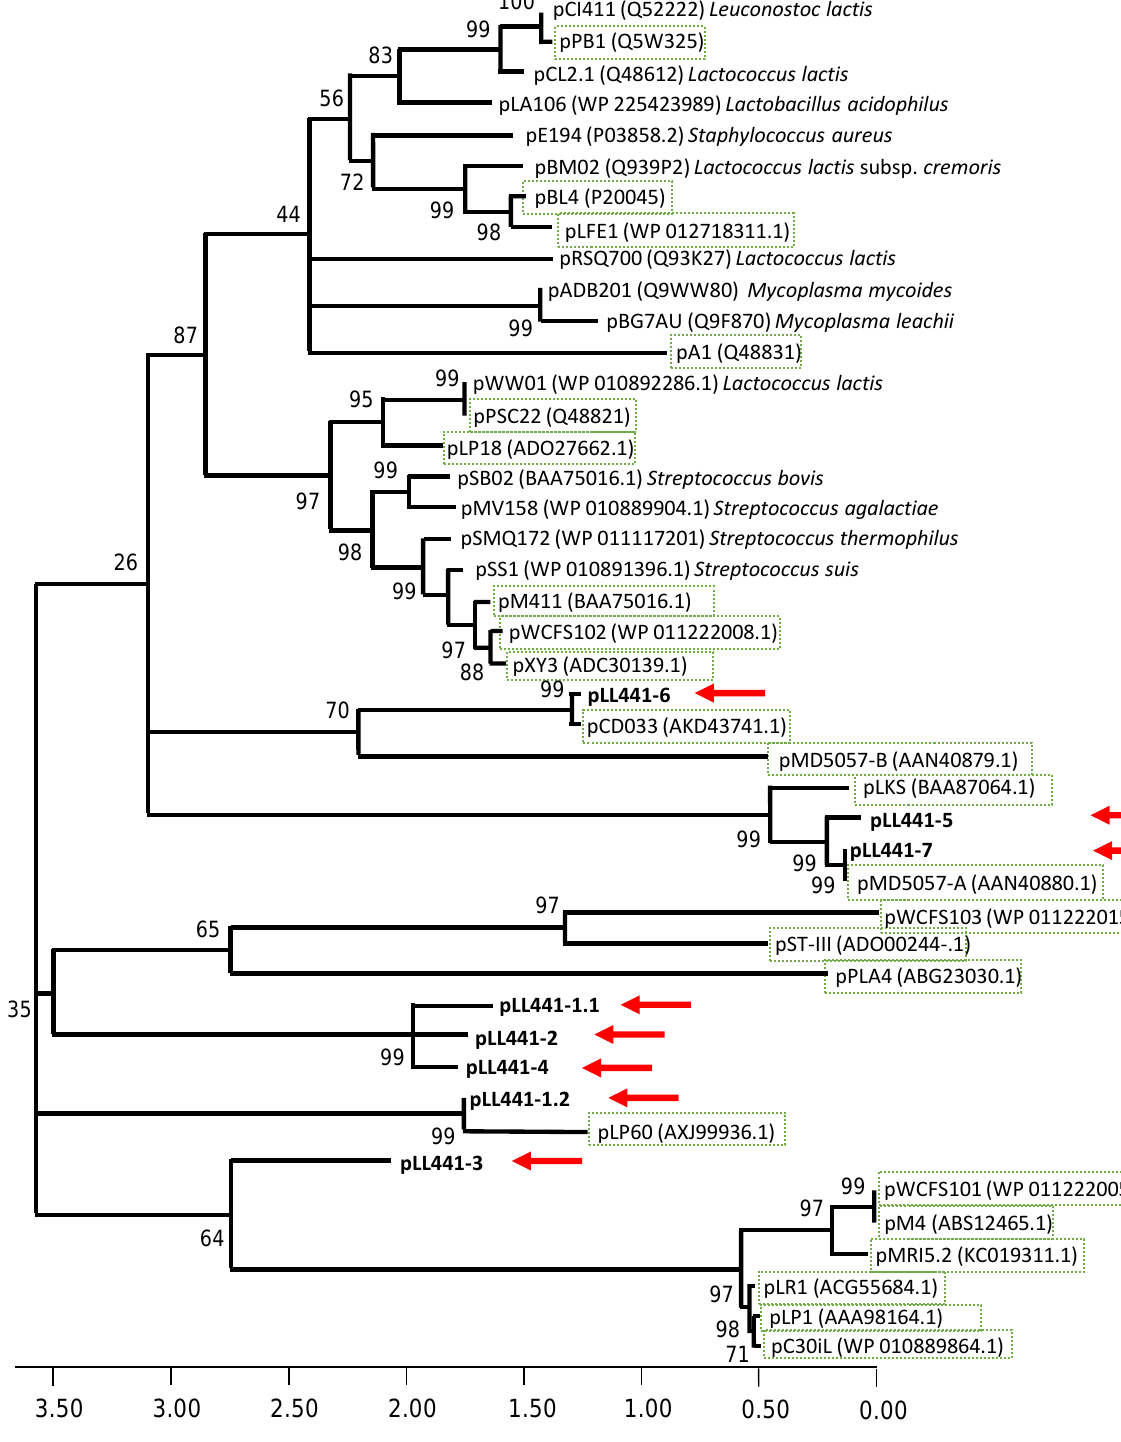
Figure 2. Dendrogram obtained with the distance matrix using the neighbor-joining method of the deduced amino acid sequences of RepB proteins from the seven plasmids of LL441 (pLL441-1 to pLL441-7) and those of other L. plantarum plasmids (boxed in green) and representative plasmid of different rolling-circle and theta-type plasmid families from other bacteria. Evolutionary distances were measured as the mean number of amino acid differences per site. The red arrows point toward the position of the L. plantarum LL441 plasmids.